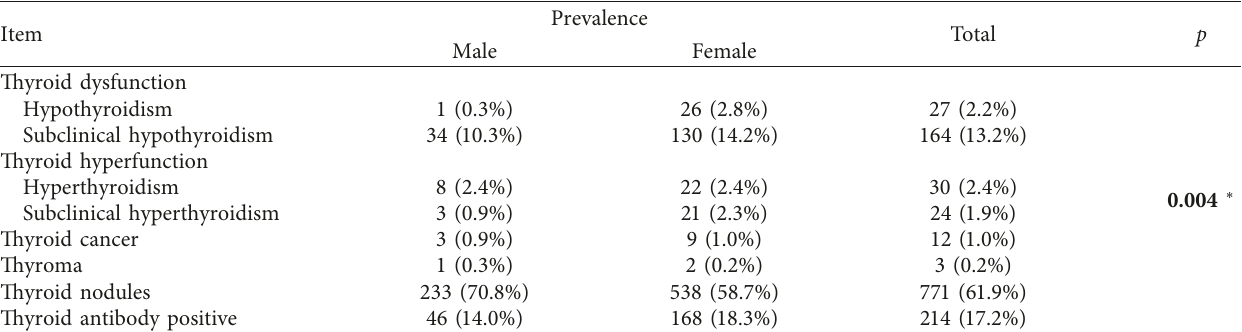
Table 2: Gender differences in the prevalence of different thyroid